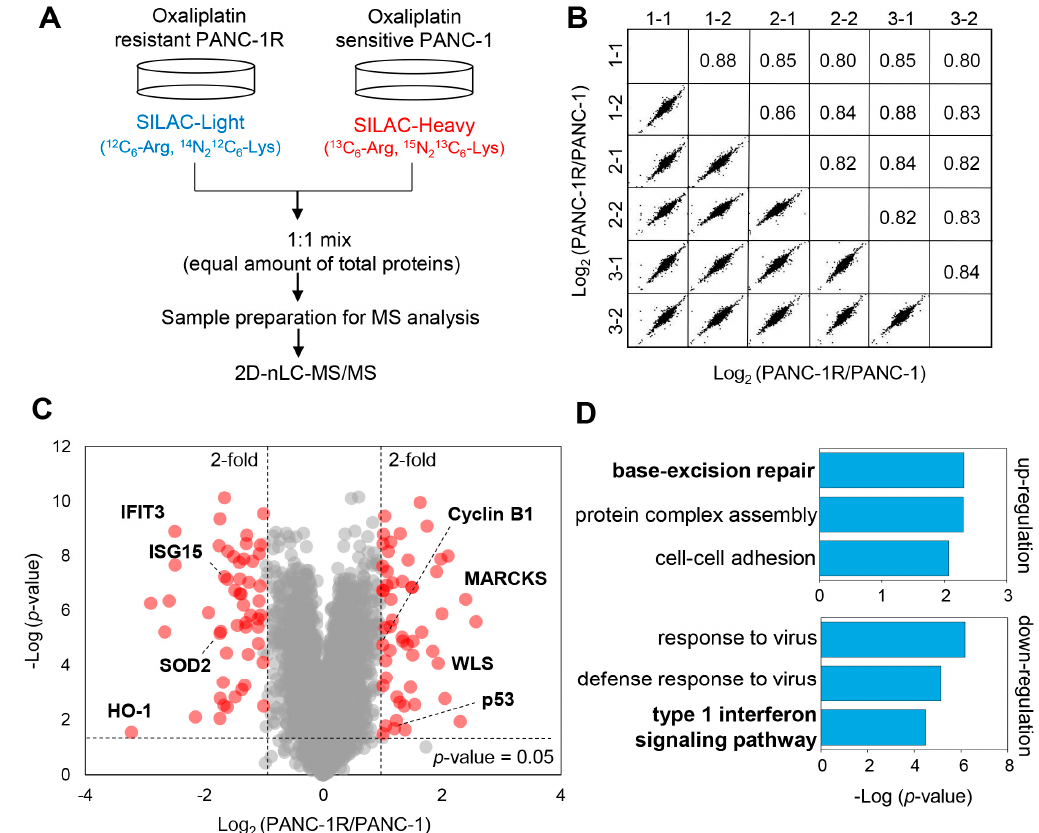
Figure 2. Proteomic comparison of oxaliplatin sensitive and resistant PANC-1 cells. ( A ) Proteomic workflow for SILAC labeling and LC-MS/MS. ( B ) Multiple scatter plots demonstrating reproducibility between the biological and technical replicates. Represented values are Pearson correlation coefficients. ( C ) Volcano plot showing the log 2 fold-change and significance ( − log 10 p -value) of the proteome dataset. The cut-off values of fold-changes and significance is indicated with a dashed line. Red dots represent significantly changed proteins according to the p -value and fold-change cut-off values. ( D ) Top 3 significant Gene Ontology (GO) terms of up/downregulated proteins by biological process.